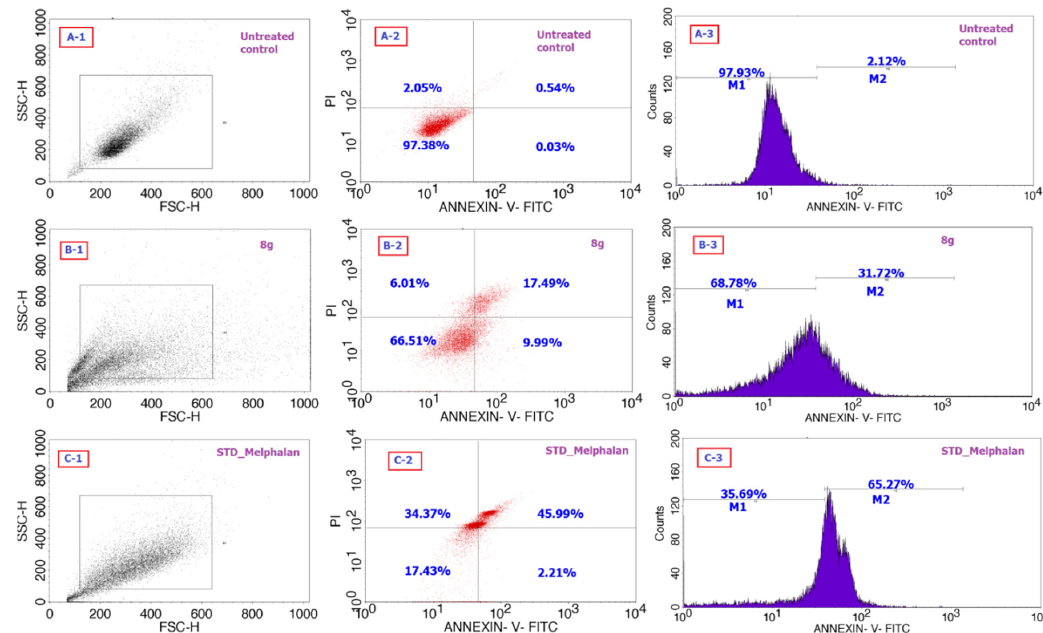
Figure 5. Apoptosis assay comparison of the fluorescence assay results following the treatment of HepG2 cells with that of the tested compound 8g ( B ). The results were compared with those of melphalan used as the positive control ( C ) and no cell treatment used as the negative control ( A ) over a 48 h period. Molecules 2020 , 25 , x FOR PEER REVIEW